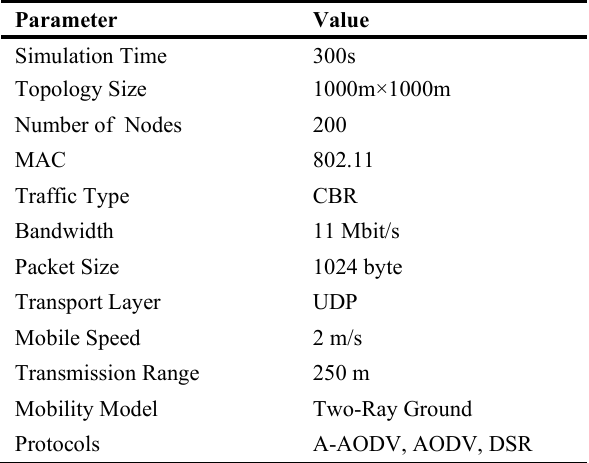
Table 1. Simulation Parameters